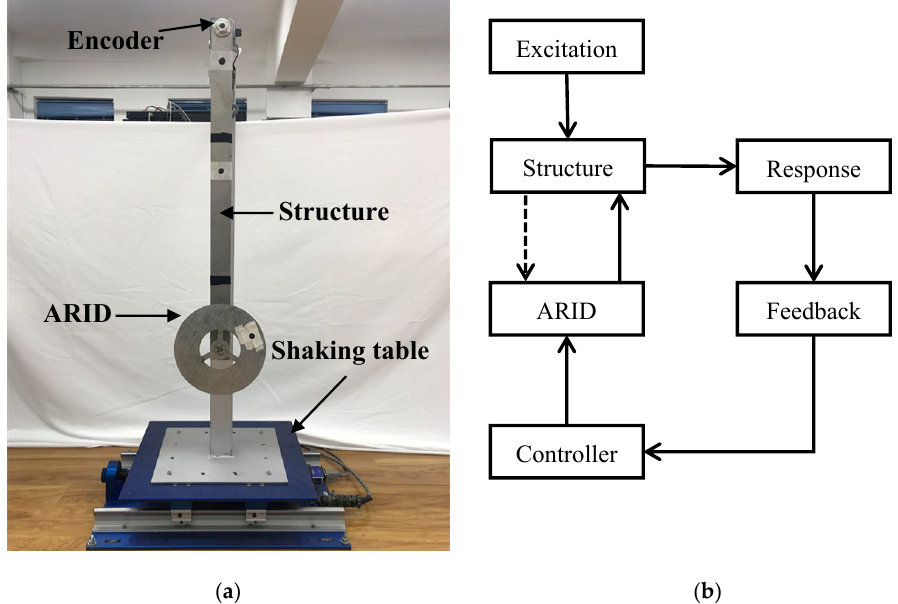
Figure 8. Sketch of experimental system: ( a ) photo of experiment setup; ( b ) control structure interaction loop of the ARID system.